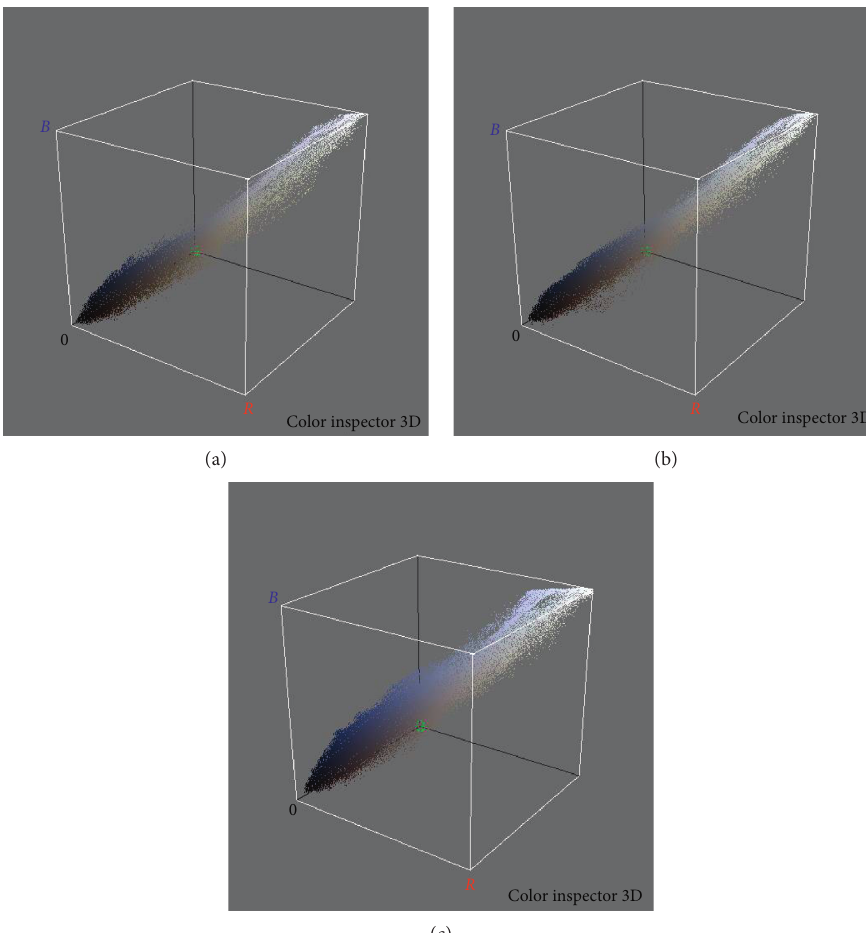
Figure 9: RGB-Model of median filtered. (a) Dry-WP170, (b) 1FT-WO170, (c)